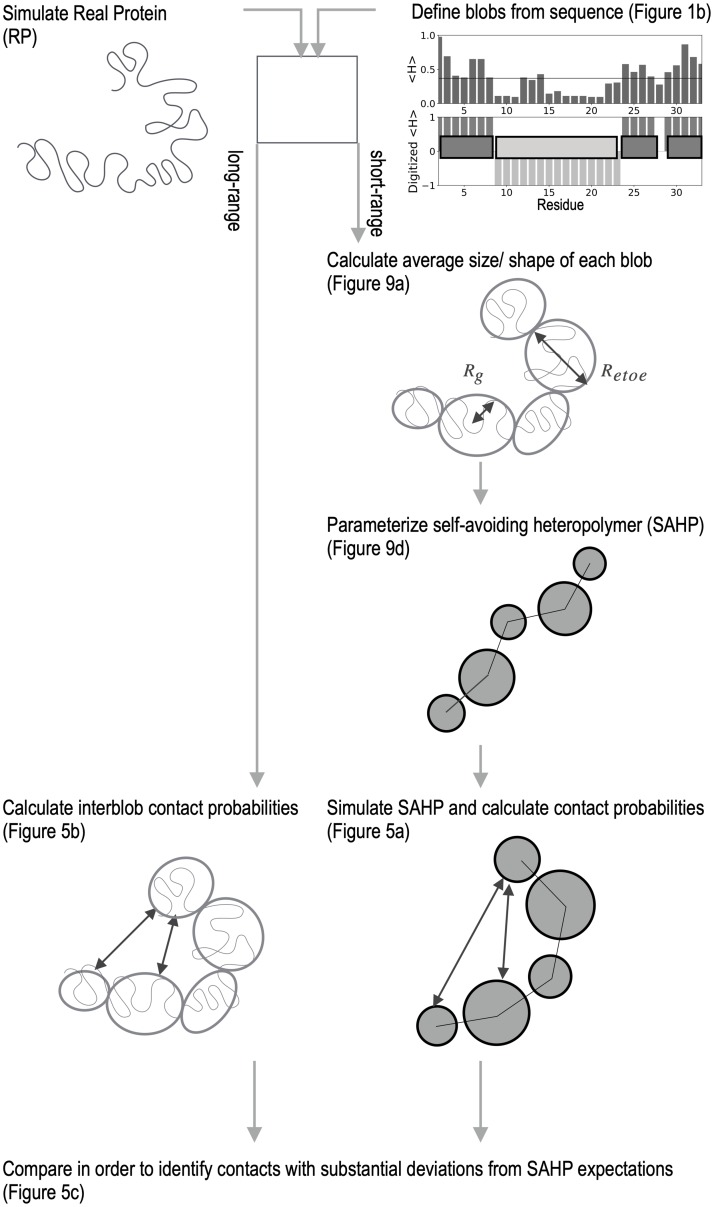
Detection of tertiary enrichment.To decouple short-range and long-range structural correlations, this work grouped segments of the protein into blobs using sequence, and then compared contacts between the blobs to those expected for an analogous self-avoiding heteropolymer (SAHP). The SAHP was parameterized by extracting local properties (size and shape) of blobs from the real protein (RP) trajectory.